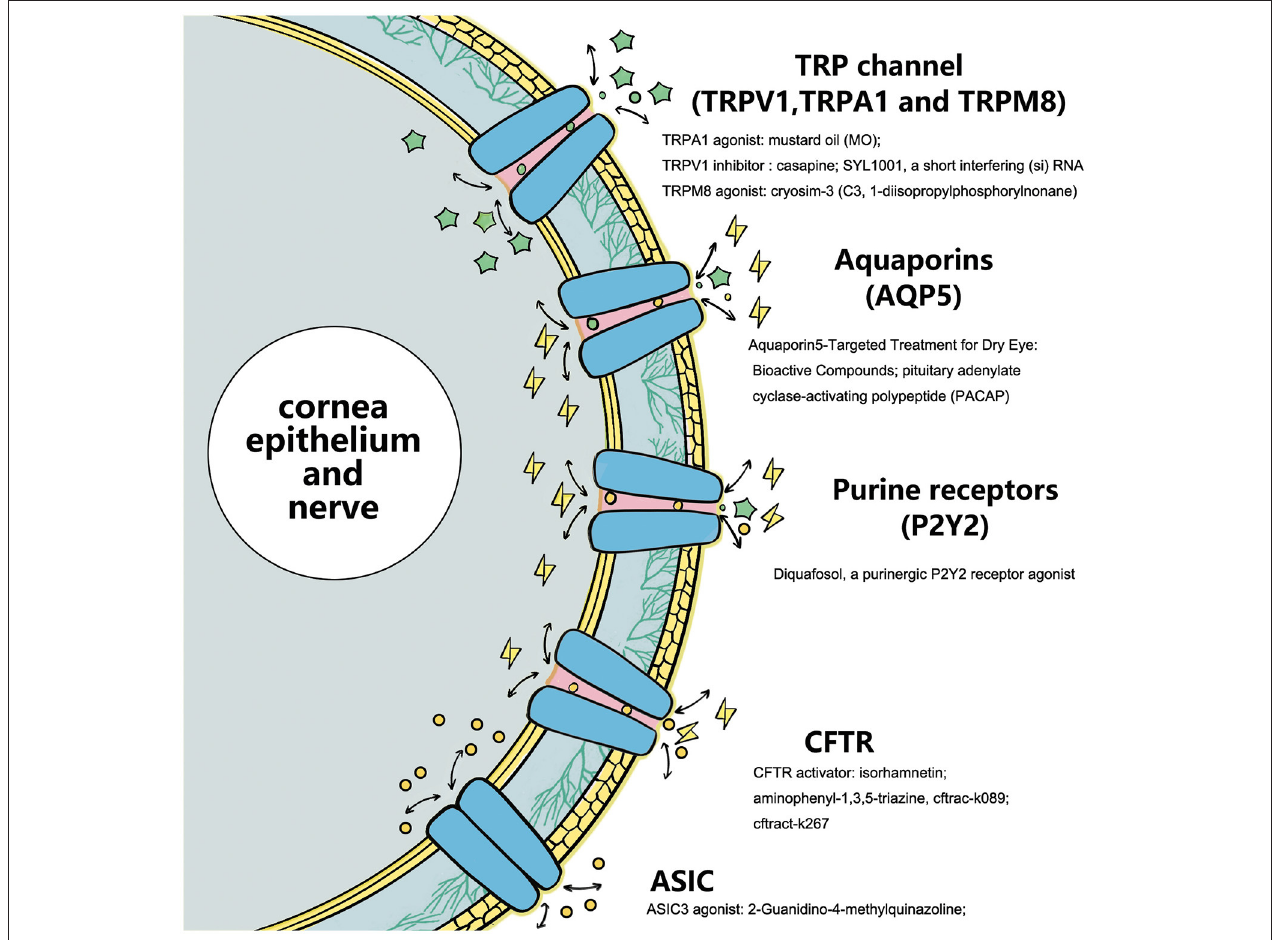
FIGURE 2 | Ion-channels target activating or inhibiting compounds as substrates for these specific receptors affect subsequent ions and intra- and extracellular information